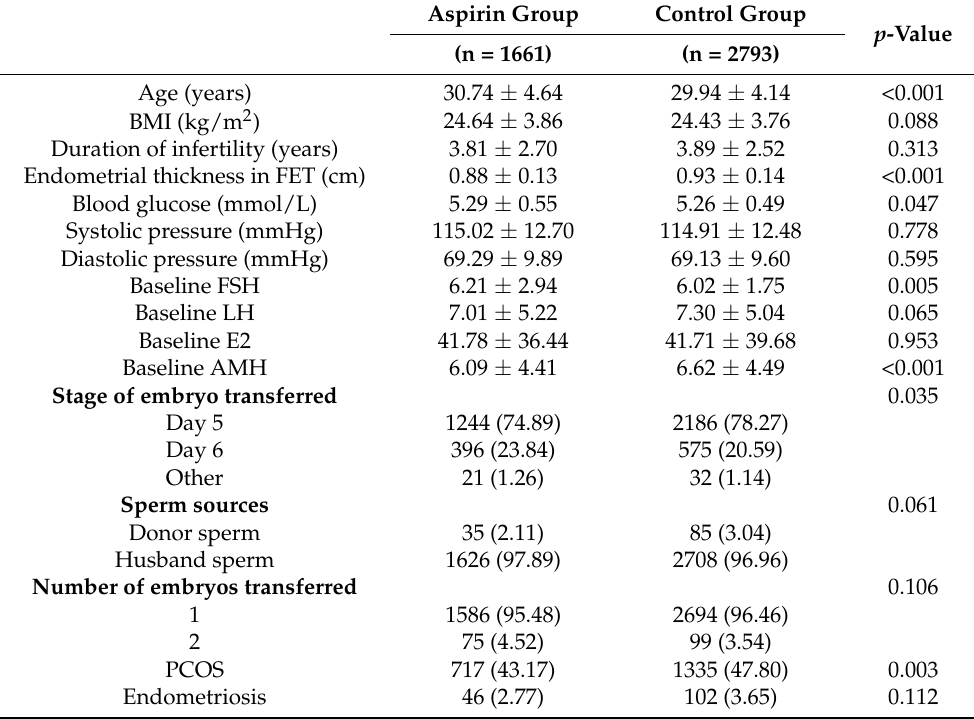
Table 1. General population characteristics of study subjects.